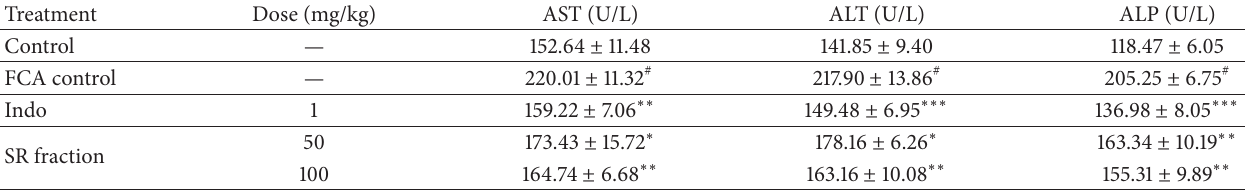
Table 5: Effect of saponin rich (SR) fraction of Achyranthes aspera on levels of tissue marker enzymes in arthritic rats serum.